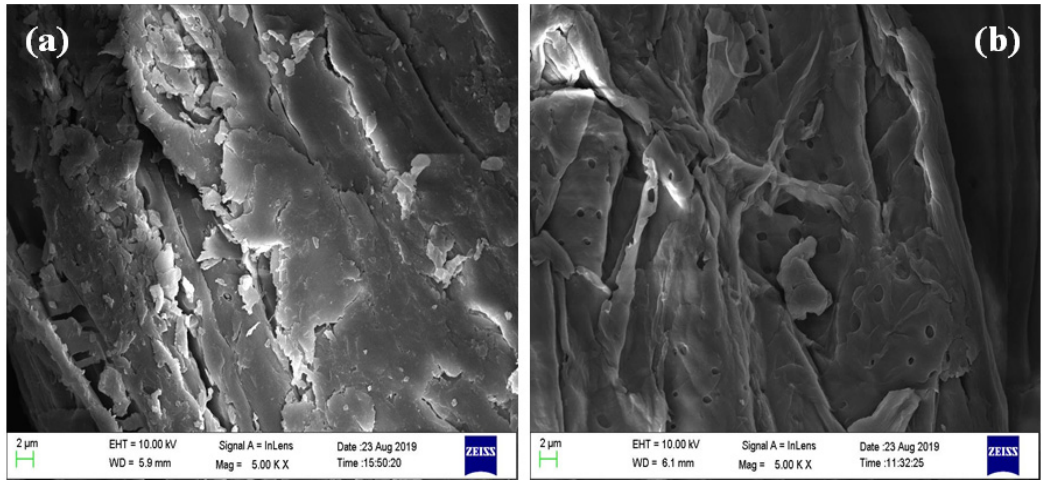
Fig. 6. (a) Raw material, (b)